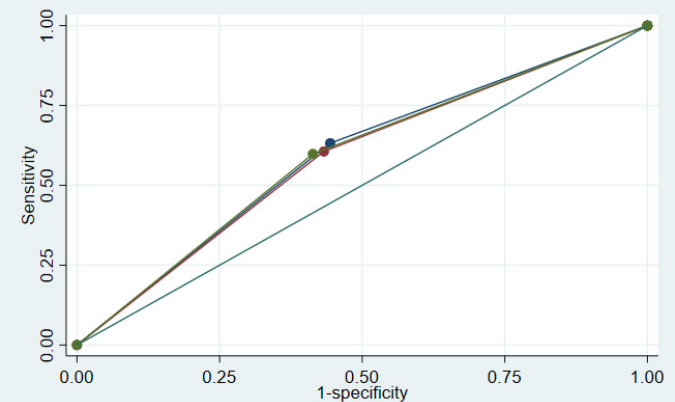
Figure 3. Receiver operation characteristic (ROC) curve of STRONGkids against acute malnutrition (green), stunting (blue), and overall malnutrition (red).